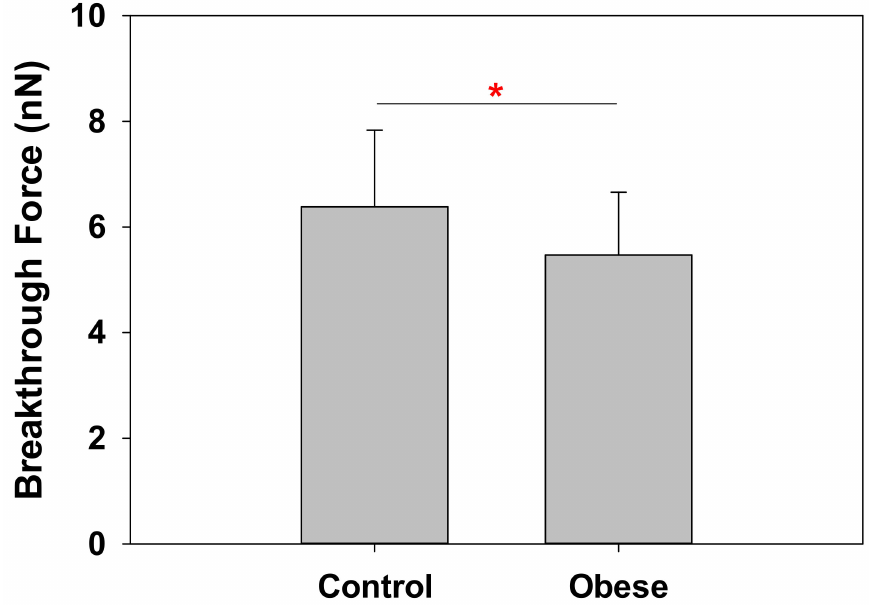
Figure 2. AFM force spectroscopy experiments on RBC. These measurements were performed at room temperature. Obese patient RBC are significantly less resistant to AFM punch-through experiments, pointing to a decrease in stiffness (number of patients n = 20 for control, n = 22 for obese; 50–75 measurements for each patient). Average values ± S.D. (*) Significance according to Student’s t-test: p =